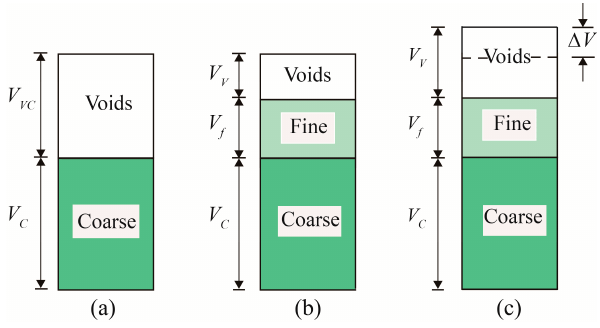
Figure 12. Phase diagrams for coarse-grained particles dominant: ( a ) pure coarse particles (before fine-grained particles added), ( b ) mixture (limiting case), ( c ) mixture (general case).